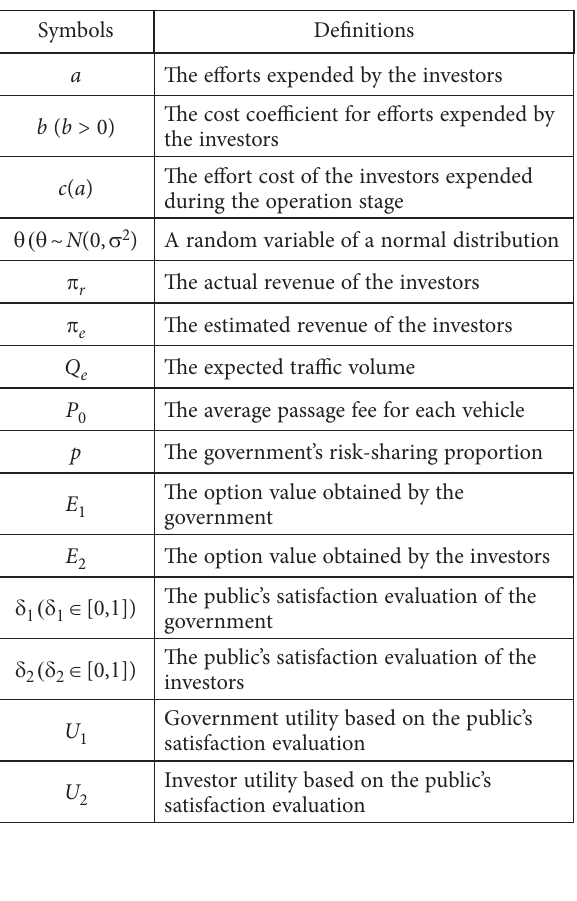
Table 1. The definitions of the variables Symbols